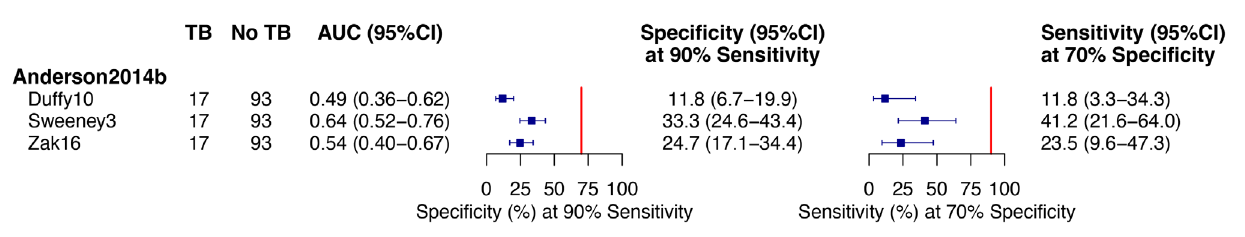
Figure 5. Transcriptomic signature diagnostic performance for non-microbiologically confirmed presumptive TB disease. Transcriptomic signature diagnostic performance for differentiation of children with non-microbiologically confirmed (i.e. presumptive clinically-diagnosed) TB disease from children with other diseases in an external validation cohort. Signature diagnostic performance (area under the curve, AUC) recalculated using participant-level data supplied by study authors, with sensitivity and specificity benchmarked against the WHO TPP minimum performance criteria for a triage test (70% specificity and 90% sensitivity, red vertical lines) 16 . 95% confidence intervals for AUC and proportions (sensitivity and specificity) were calculated using the DeLong 30 and binomial proportion (Wilson) 31 methods, respectively.